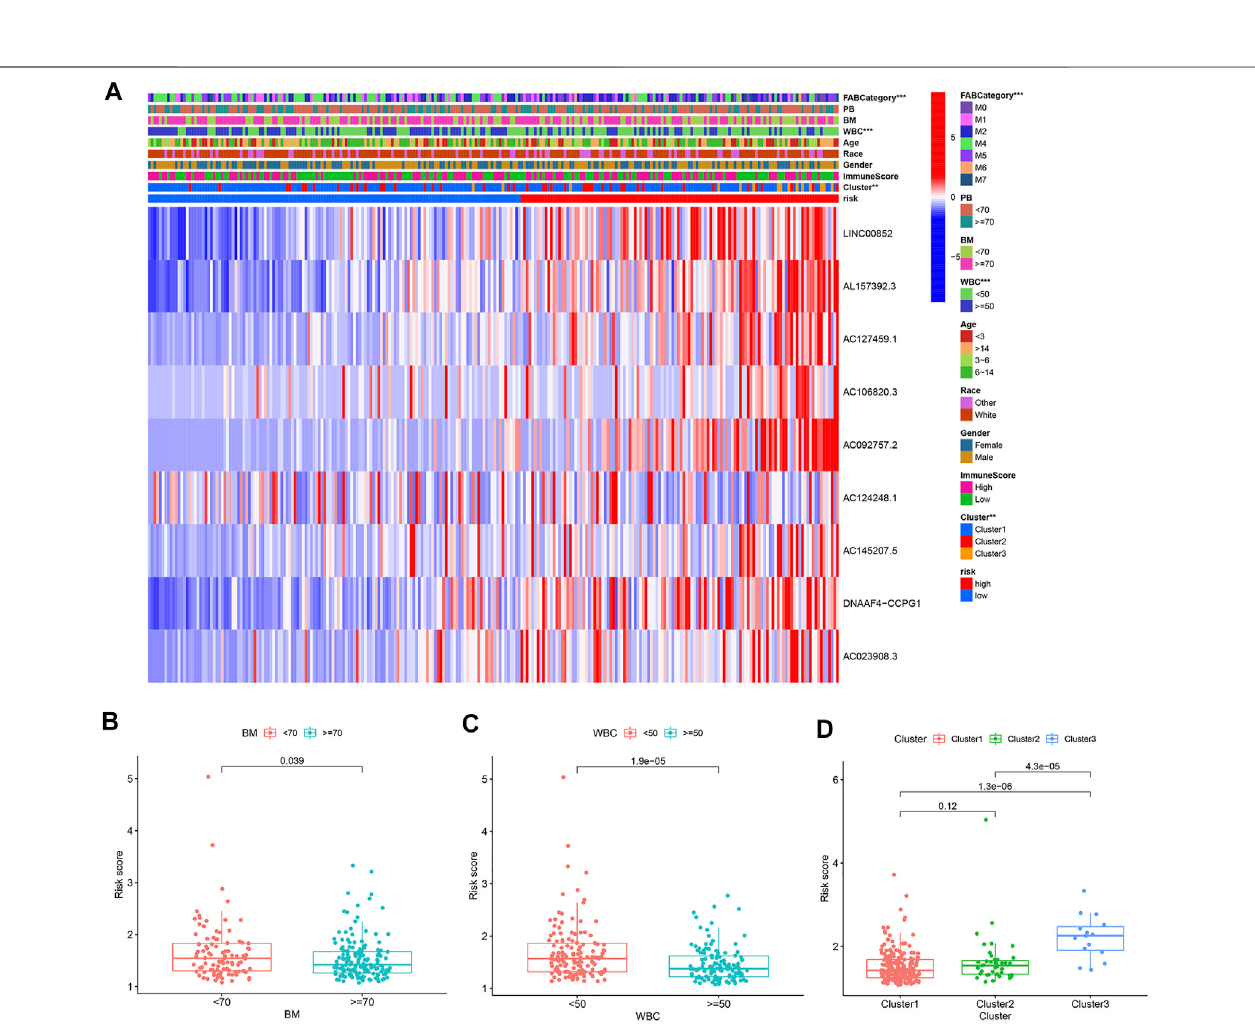
FIGURE 6 | Risk score correlated with clinicopathological features and immune scores in AML. (A) Heatmap revealed a signi fi cant FAB category, age, BM, PB, WBC, race, gender, immune score, and cluster between the high-risk and low-risk groups. (B – D) Risk score in different clinicopathological features. (B) Bone marrow leukemic blast percentage (%). (C) WBC at diagnosis. (D) Cluster. Bone marrow leukemic blast percentage (%) (BM), peripheral blasts (%)